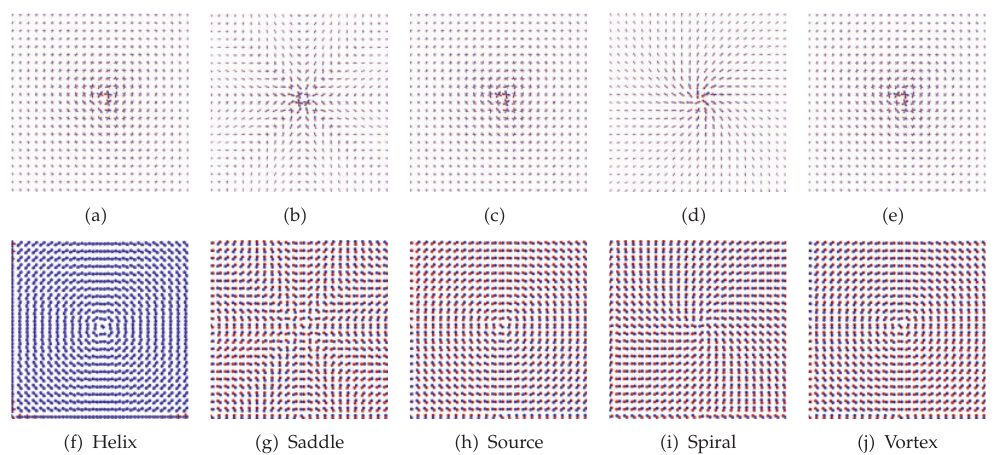
Figure 2: Lamb tensor (cid:3) top row (cid:4) and Helicity tensor (cid:3) bottom row (cid:4) of synthetic second-order tensor fields. The Lamb vector characterizes shear in the tensor field. Positive lobes are plotted in blue, and negative lobes are red. Note that the shear is primarily in an outward radial direction for all fields except for the saddle where the shear is directed inward. This makes the saddle feature easy to identify using the divergence of the Lamb tensor. The helicity tensor has both positive and negative lobes (cid:3) and trace (cid:7) 0 (cid:4) for all features except the helix.